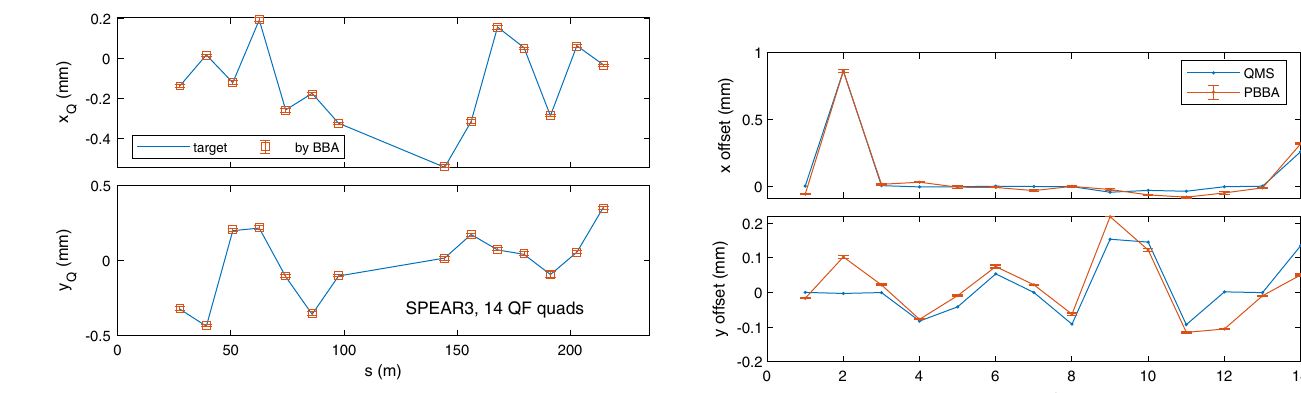
FIG. 12. The quadrupole center offsets from the initial beam orbit as measured by PBBA in experiment are compared to the QMS